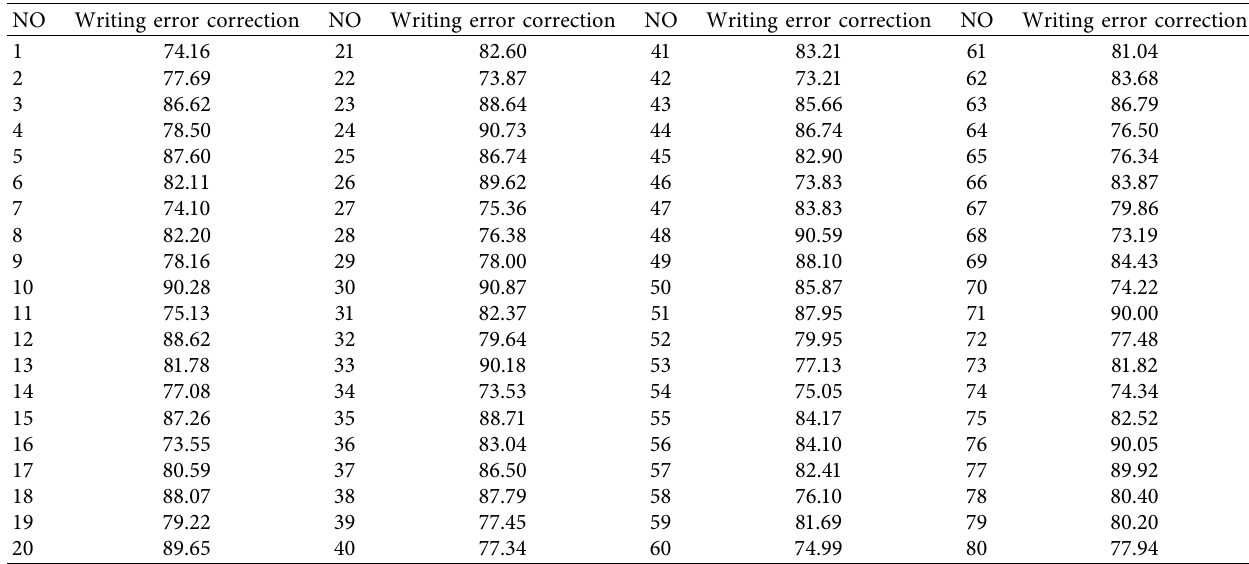
Table 2: English writing error correction effect of English writing correction model based on intelligent text semantic analysis. NO Writing error